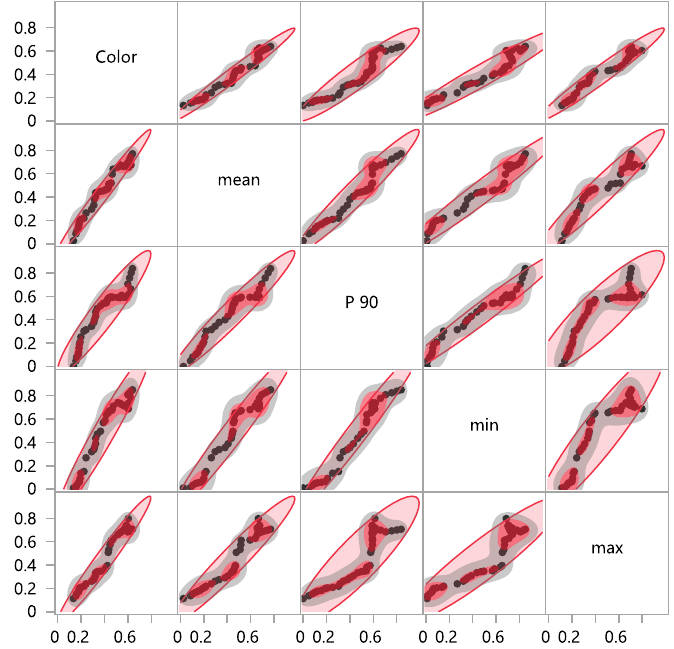
Figure 5. Scatter plot matrix of MCI—actual and different zonal estimated values.